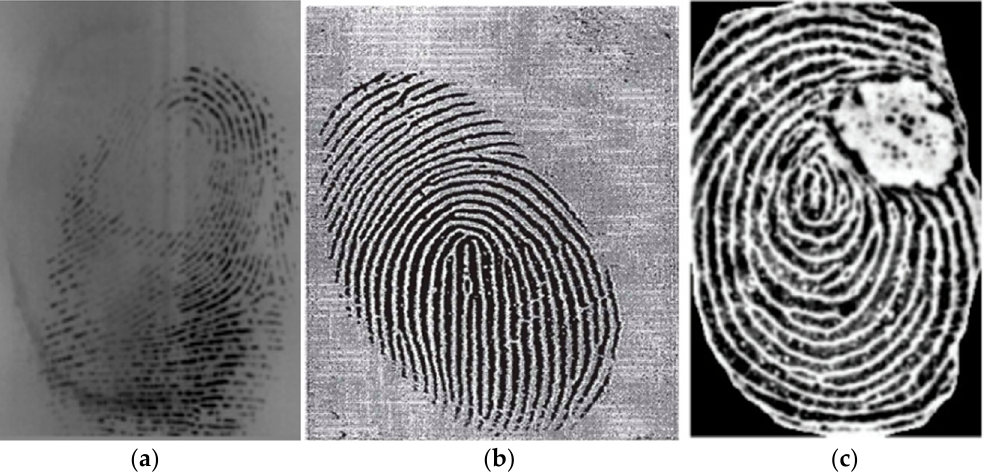
Figure 1. Different challenges for contact-based fingerprint images: ( a ) blurry images, ( b ) distorted image capture, ( c ) deformed images [21–23].